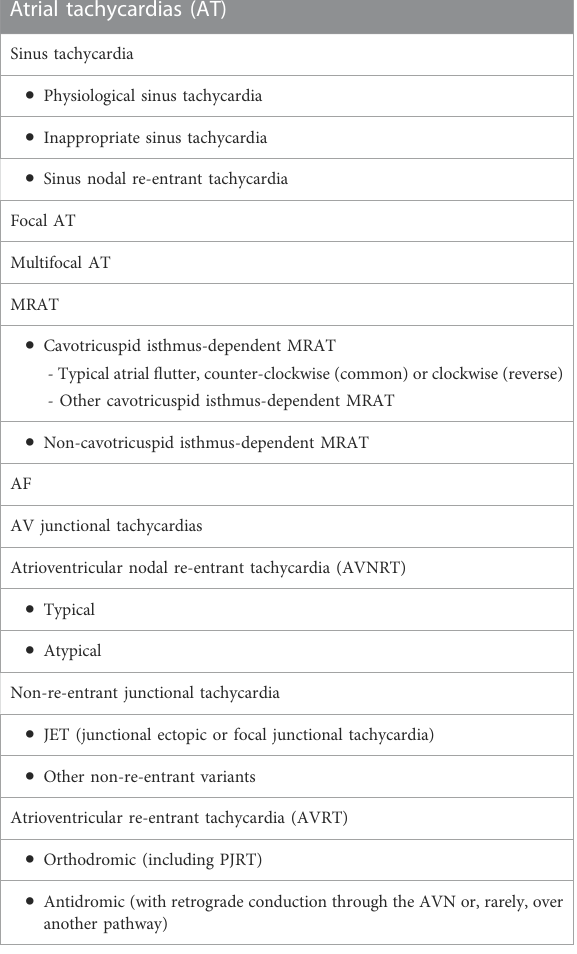
TABLE 2 Supraventricular tachycardia (SVT) – classi fi cation (Brugada et al., 2020). Atrial tachycardias (AT) Sinus